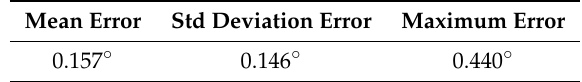
Table 4. Errors in the calculation of the rotation angle using Emitters 1 and